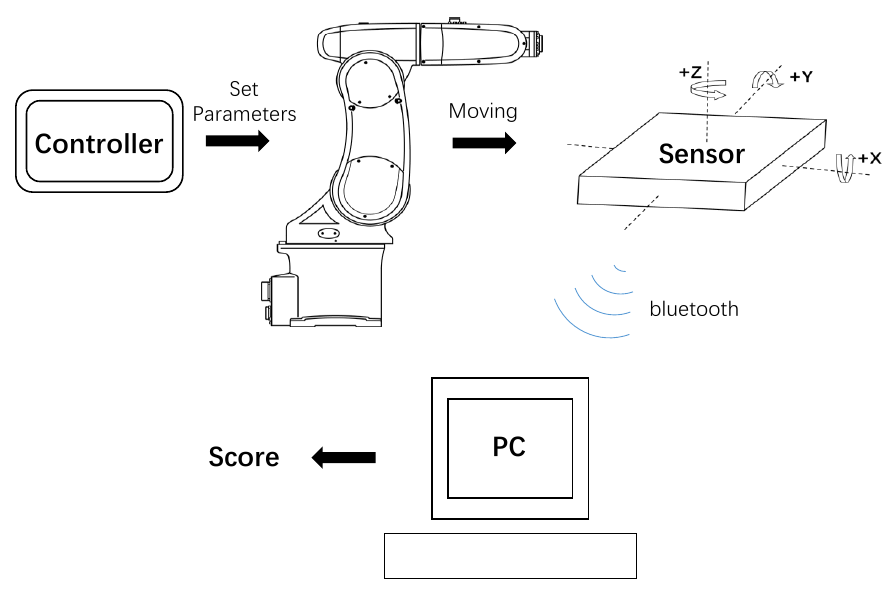
Figure 2. System